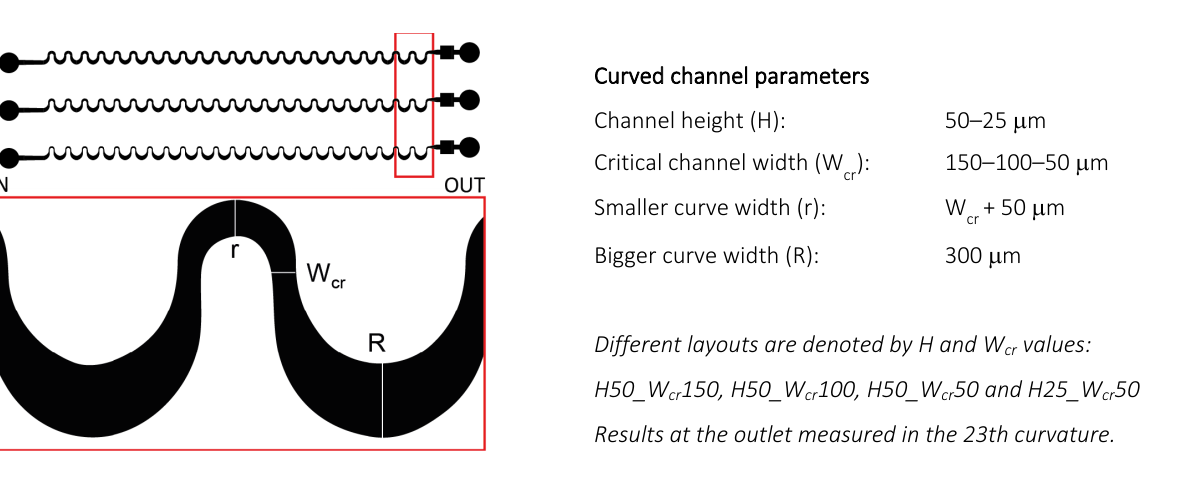
Figure 1. The schematic design of the lithographic mask representing the obtained geometrical parameters of the periodic sequence of the microchannels. The red box indicates the magnified area of the mask layout.